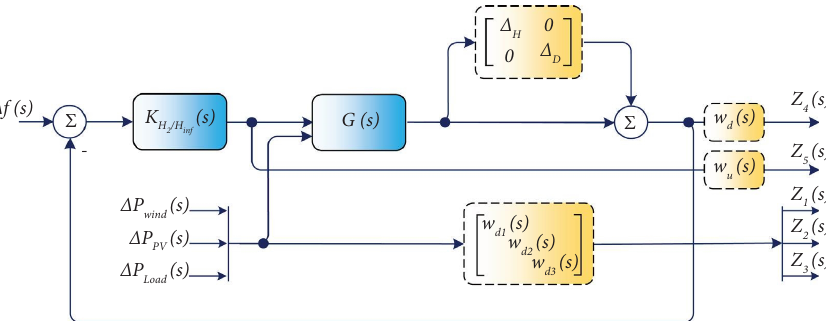
Figure 6: Te structure of the closed-loop system with multiplicative